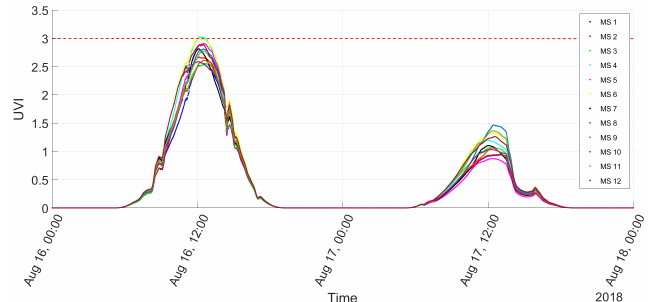
Figure 10. UVI measured by the 12 measurement stations of inside the greenhouse for two consecutive days (without and with whitewashing,